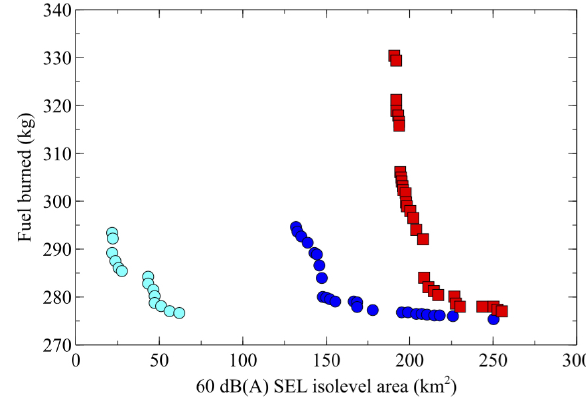
Figure 15: Pareto front limited to tonal fan noise and buzz-saw noise (light blue dots), compared to the total noise front with (blue dots) and without (red squares) low noise